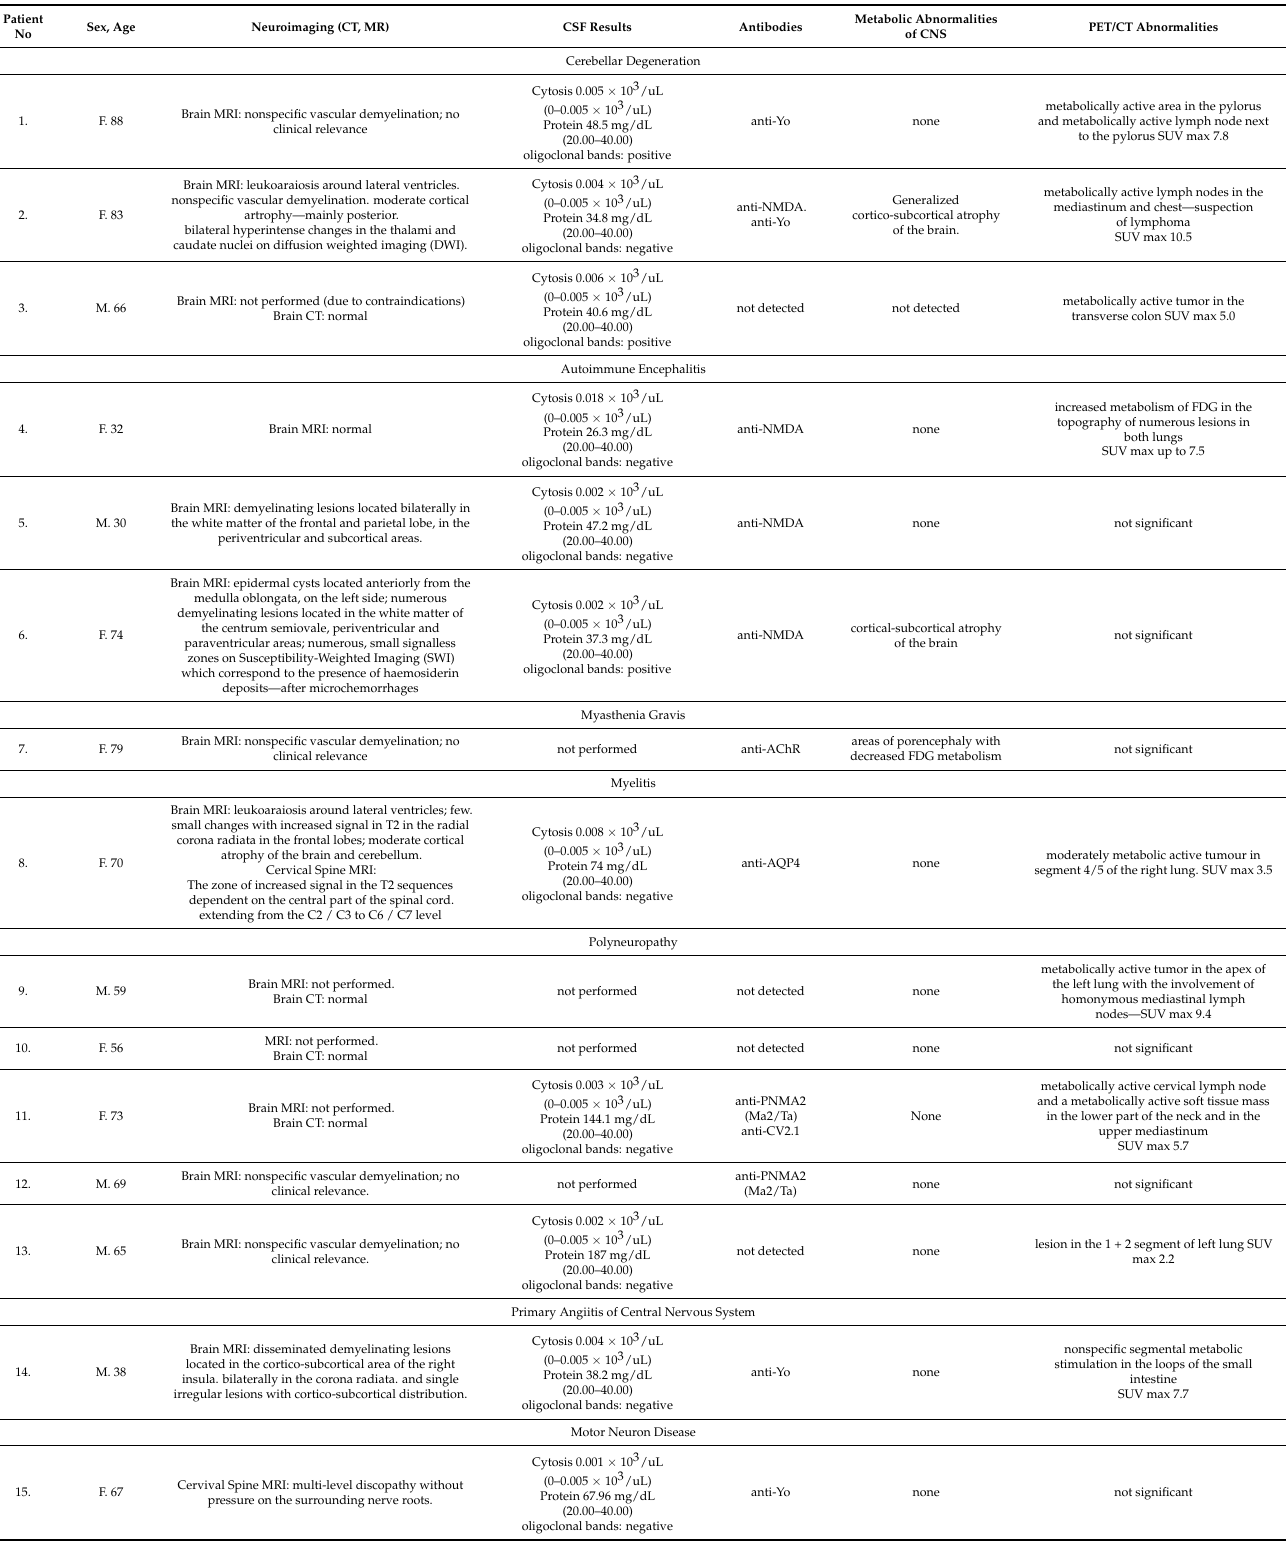
Table 5. Clinical. biochemical. and imaging data of patients included in the